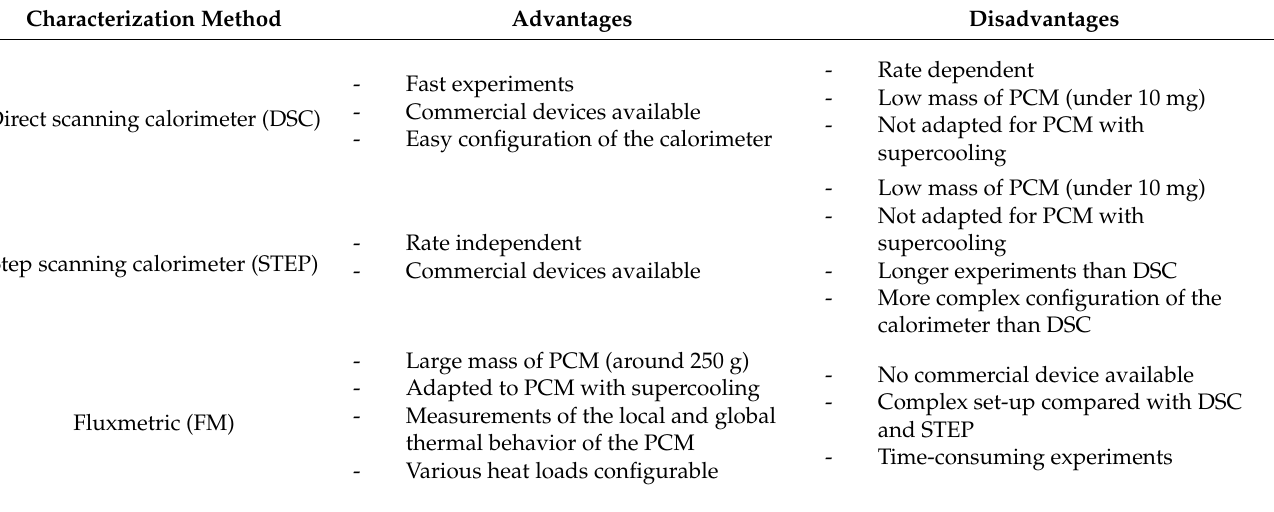
Table 2. Synthesis of advantages and disadvantages of the three characterization methods studied. Characterization